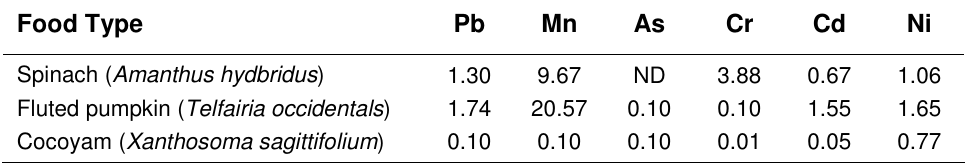
Concentration of Metals in mg/kg of Food Harvested from Dump